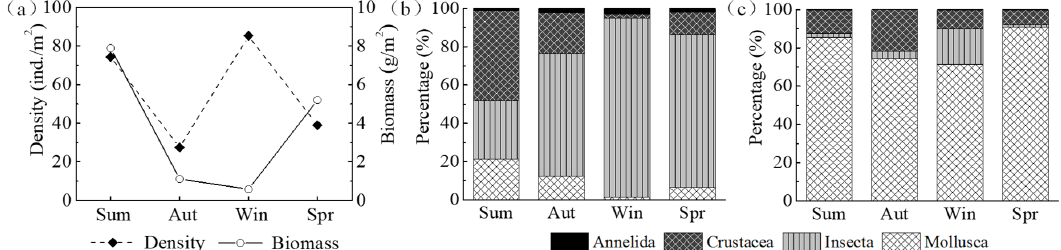
Figure 5. Seasonal changes of macroinvertebrate density and biomass ( a ), the percentage of different components in density ( b ), and biomass ( c ) in the typical reaches of the Huai River basin. The ind. represents individuals.